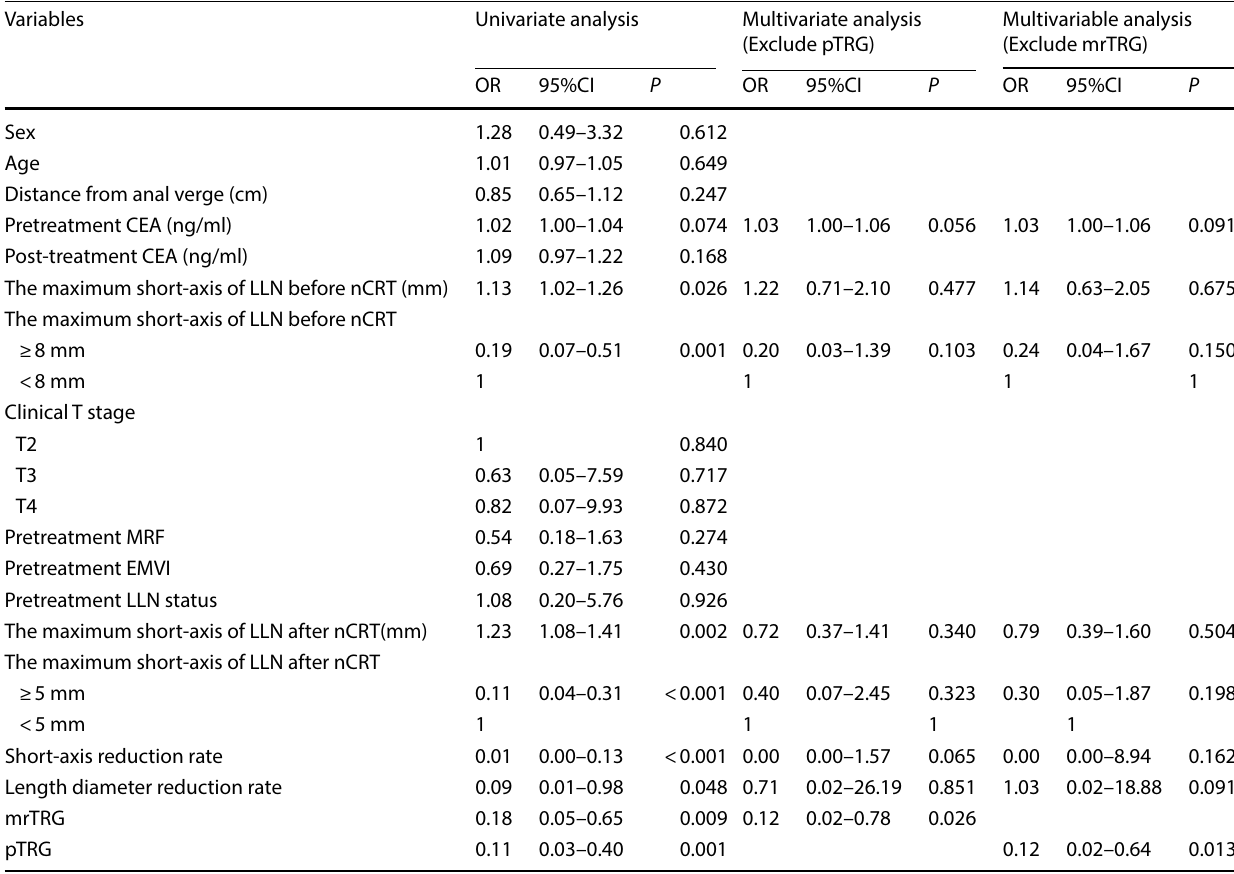
Table 3 Logistic regression analysis of clinicopathological features and image data grouped by